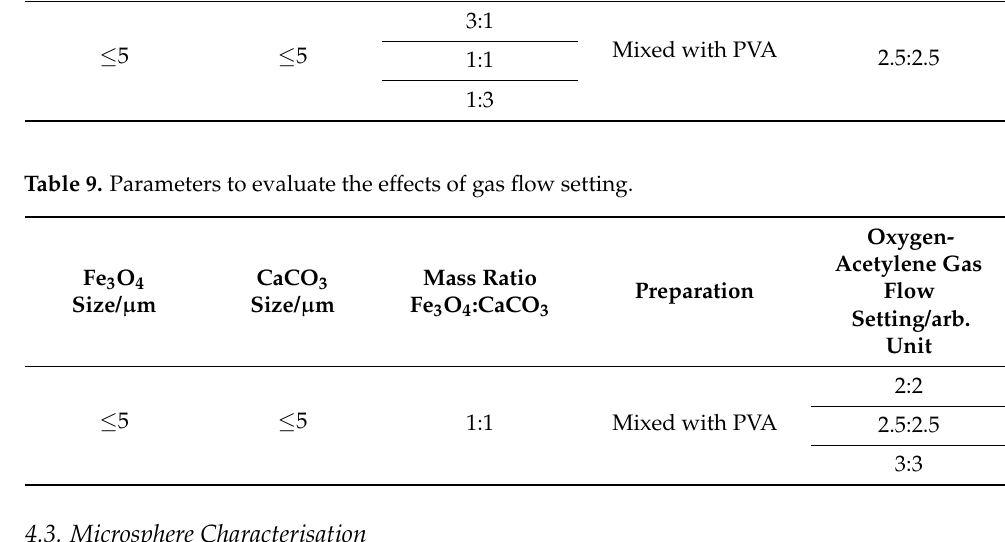
Fe 3 O 4 Size/ µ m